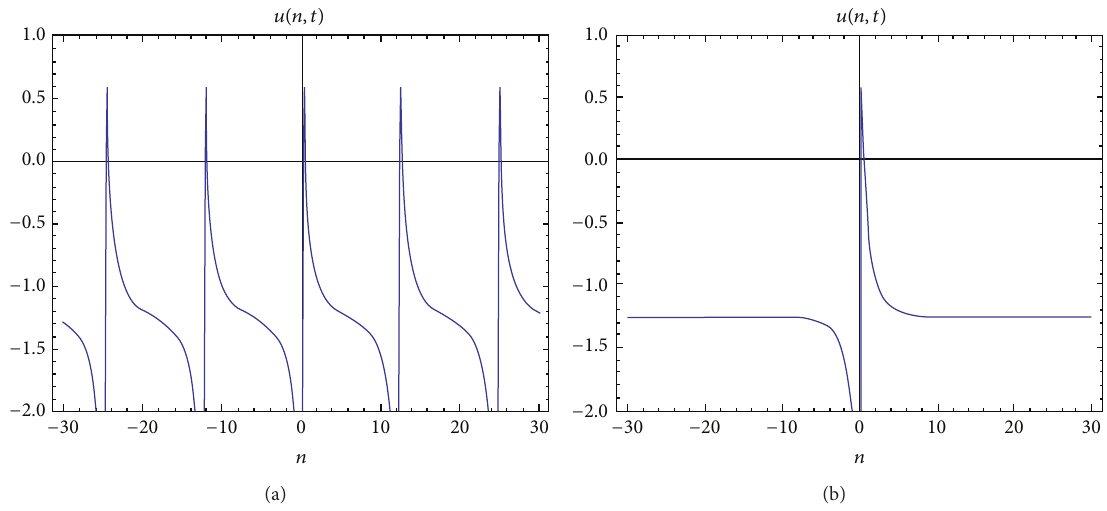
Figure 1: The 2nd-order approximate solution (31), respectively, when 𝜇 = 0.5 and 1 at ℎ|